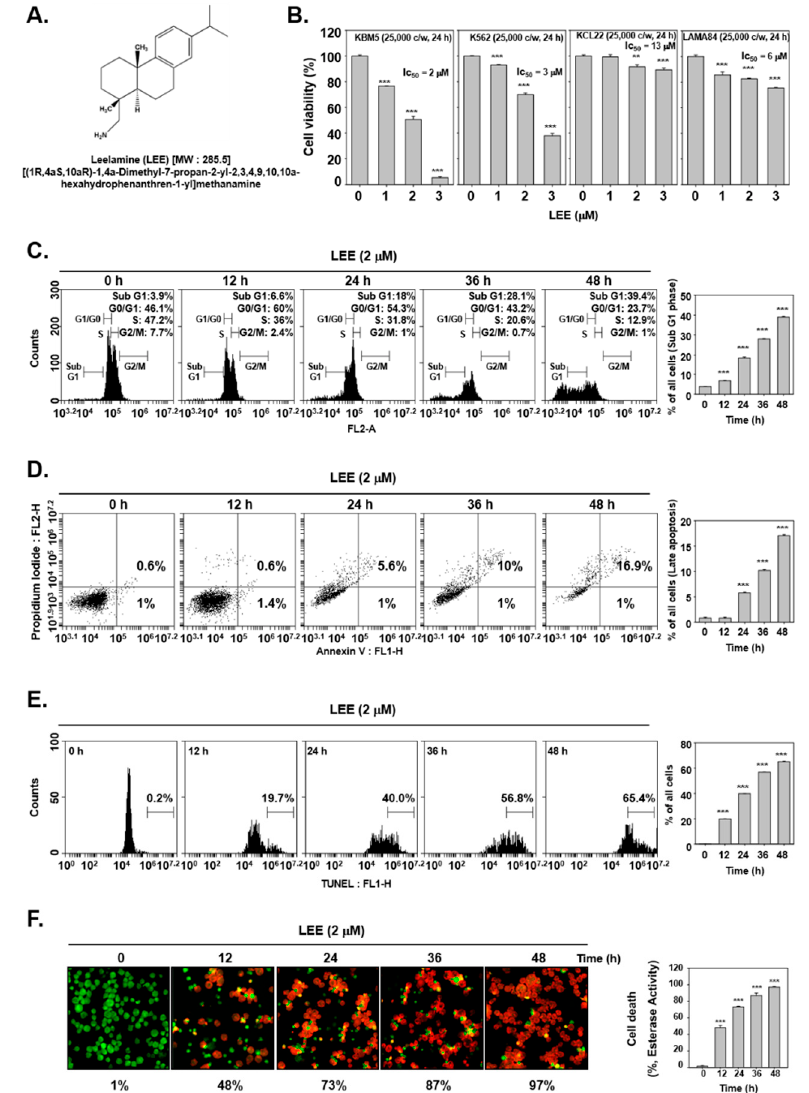
Figure 1. Effects of LEE on apoptosis induction in KBM5 cells. ( A ) Chemical structure of LEE (Leelamine). ( B ) KBM5, K562, KCL22, and LAMA84 cells (2.5 × 10 4 cells/well) were treated with LEE for 24 h, then cell viability was measured by MTT assay. ( C ) KBM5 cells (5 × 10 5 cells/well) were treated with LEE (2 µ m) for indicated time intervals (0, 12, 24, 36, 48 h). Cells were digested with RNase A for 1 h, and stained with propidium iodide (PI) and then analyzed by flow cytometric analysis. ( D ) LEE (2 µ m) treated KBM5 cells were incubated with Annexin V-FITC and PI for 15 min. Apoptosis was measured by flow cytometric analysis. ( E ) KBM5 cells were treated with LEE, then fixed and stained with TUNEL assay reagent. ( F ) Live and dead assay was performed with KBM5 cells. *** p < 0.001 vs. non-treated (NT) cells, ** p < 0.01 vs. non-treated (NT) cells vs.